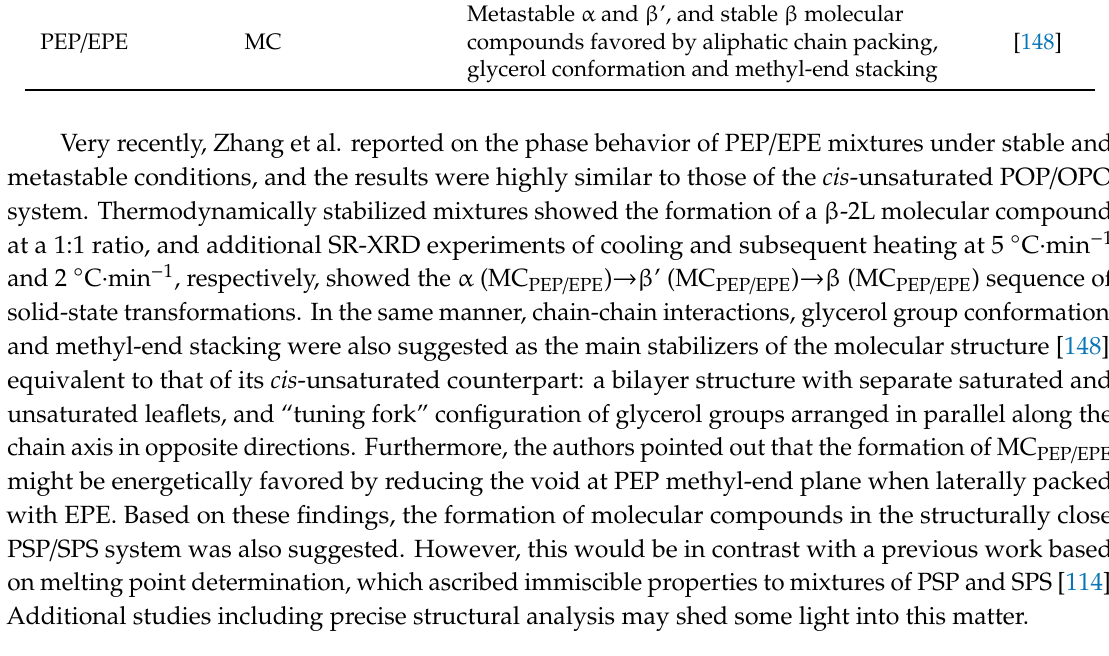
Table 7. Phase behavior in binary mixtures of saturated- trans -unsaturated mixed-acid TAGs. TAG System Phase Behavior Integration of TAGs in the same crystal lattice favored by molecular similarity between S and E Solid solution fatty